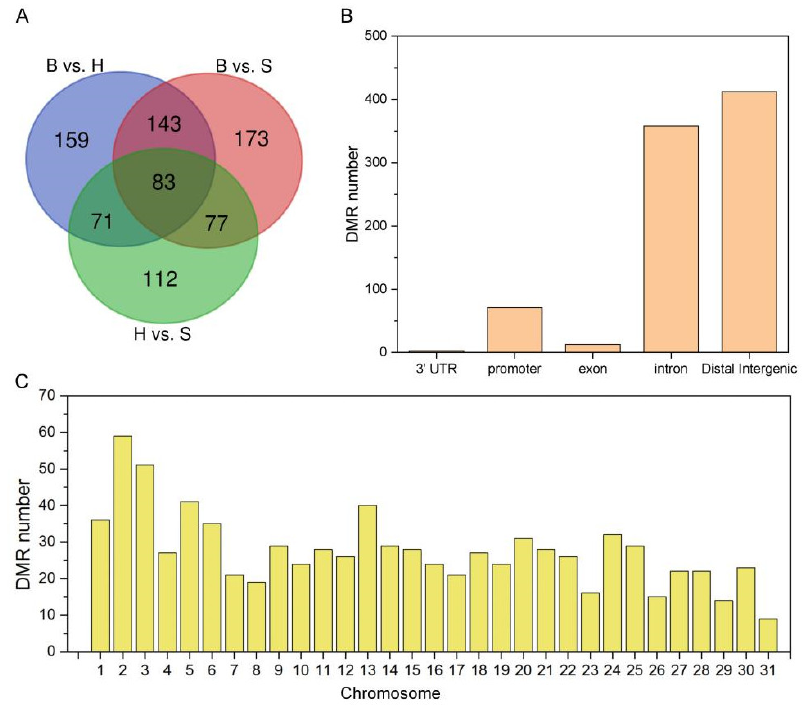
Figure 4. Genomic distribution of DMRs among the holdfast, stipe and blade of sporophytes. ( A ) Venn diagram of DMR numbers identified in “B vs. H”, “B vs. S” and “H vs. S” groups. B, H, and S are the samples of blade, holdfast, and stipe, respectively. ( B ) The distribution of DMRs in different genomic regions, including 3′UTR, promoter, exon, intron and distal intergenic. ( C ) The detailed distribution of DMR numbers in the 31 chromosomes of sporophytes.